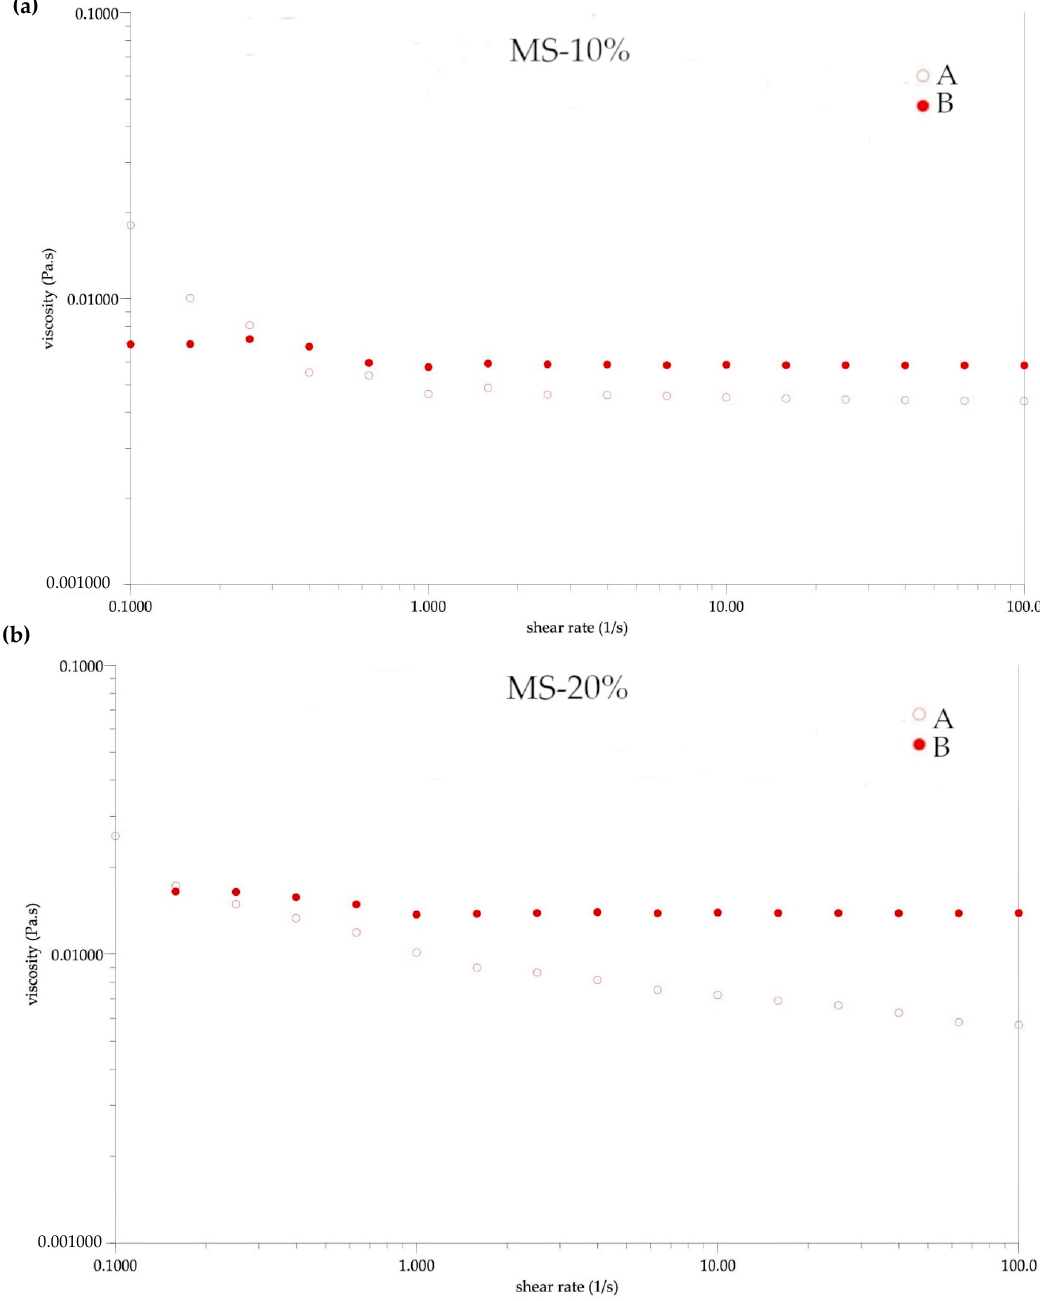
Figure 5. The flow curves of emulsions without FOCE before spray drying A and after reconstitution B. ( a ) MS-10%— emulsion without FOCE with 10% of flaxseed oil; ( b ) MS-20%—emulsion without FOCE with 20% of flaxseed oil.